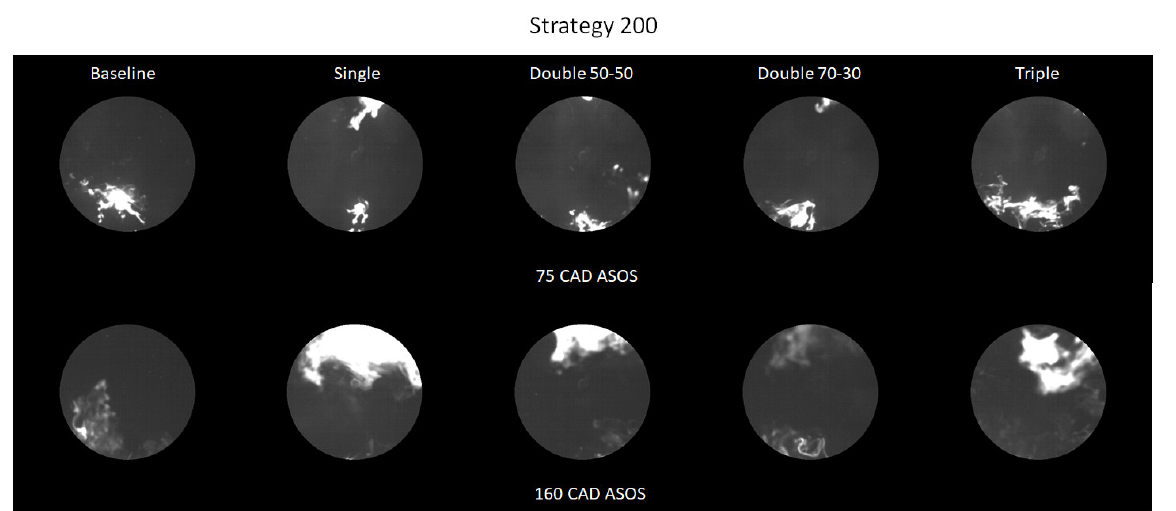
Figure 15 . Image sequence of late combustion stages at 75 and 160 CAD ASOS, for the 250-injection strategy.